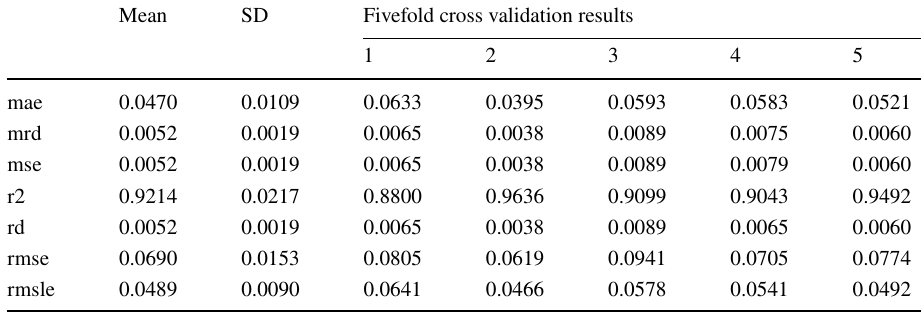
Fig. 7 Experimental and predicted relative permeability models using neural network with and without cross valida- tion and deep neural networks on the validation set. The neural network model with cross validation (cv) partitioned the dataset into fivefold and then trained and tested the model using the different